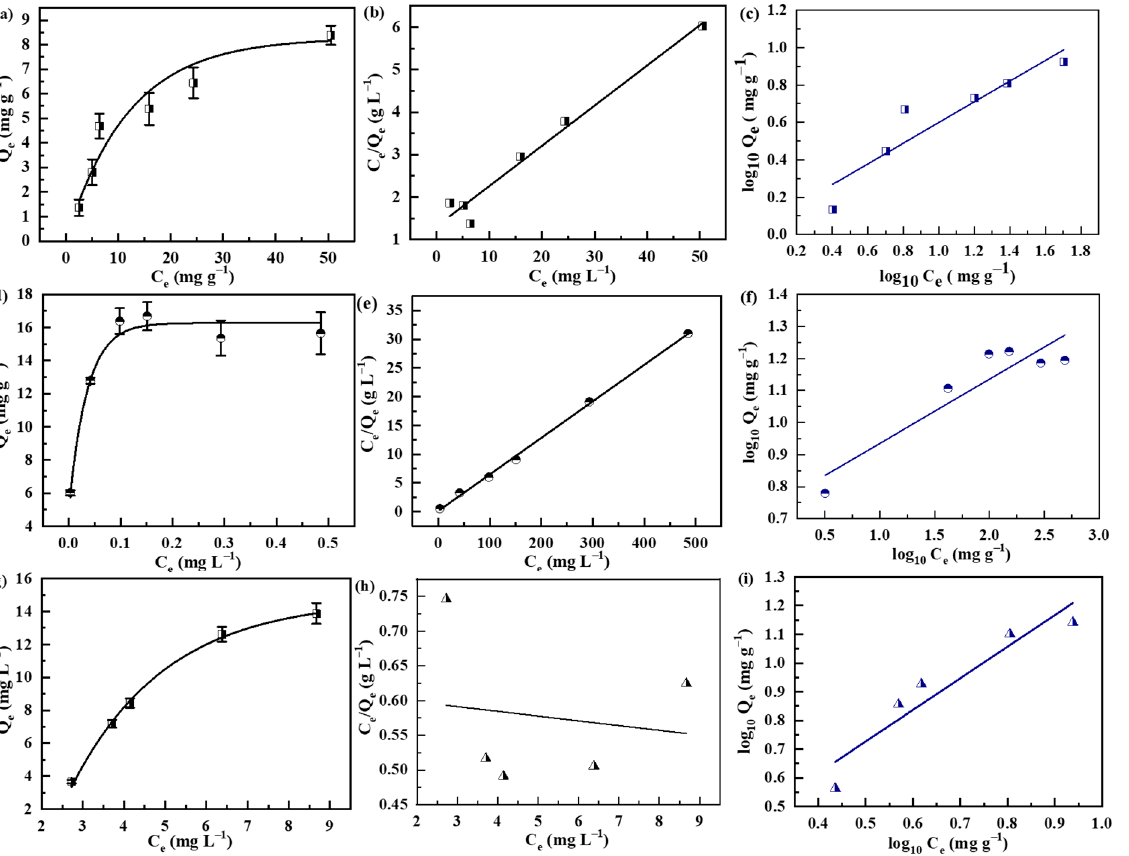
Figure 4. ( a , d , g ) Adsorption isotherms, ( b , e , h ) Langmuir fitting curves and ( c , f , i ) Freundlich fitting curves of the adsorption of pollutants by SPS foams. Square: Pb 2+ , circle: lysozyme and triangle: MB. Table 1. Fitting the equilibrium data using the Langmuir and Freundlich models. Sorbates